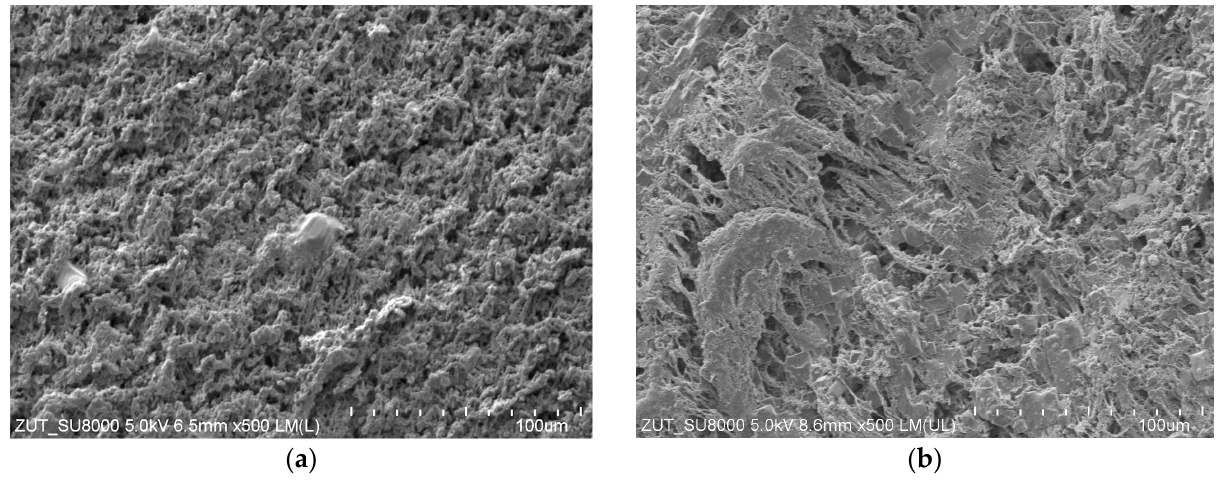
Figure 8. SEM images of the membrane surface. Membrane collected from: ( a ) M3 module—membrane V8, ( b ) M4 module—membrane V8N. MDC process presented in Figure 7.